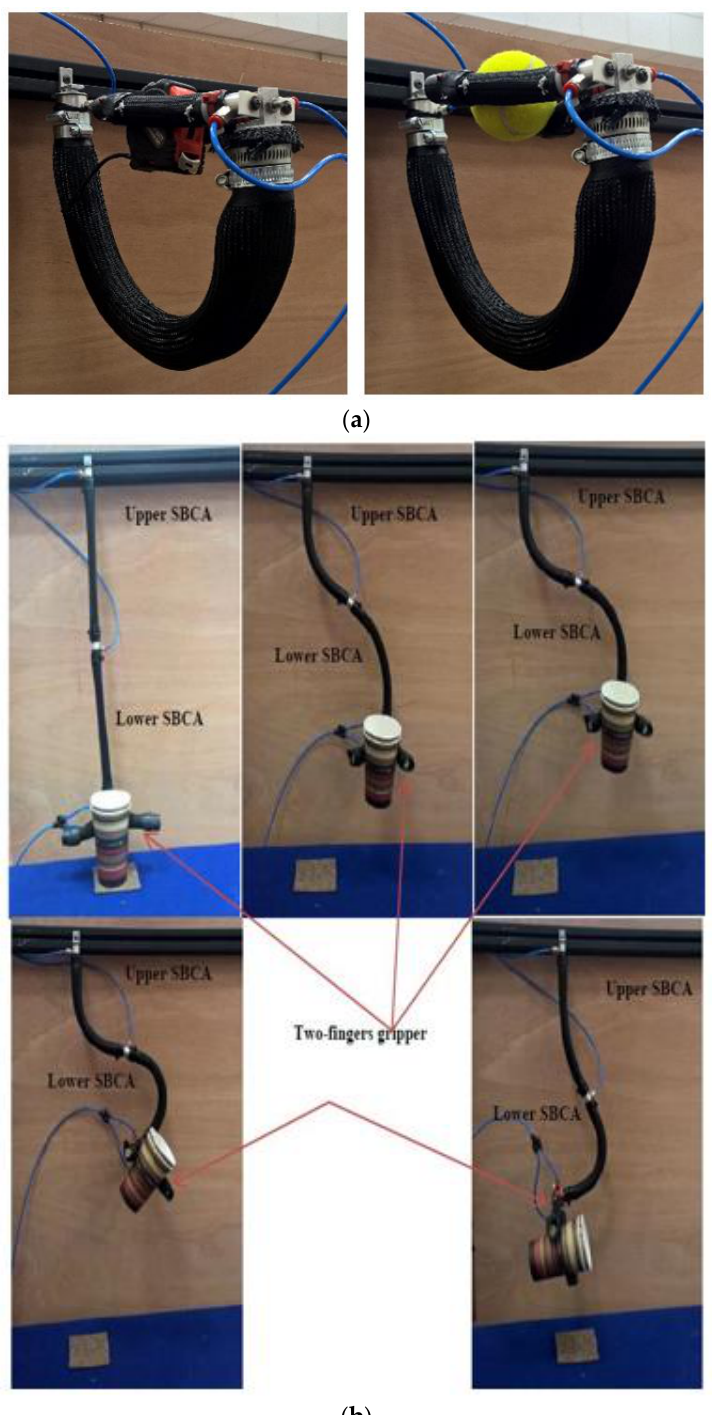
Figure 13. Continuum arms based on SBCA and a two-finger soft gripper. ( a ) A single SBCA. ( b ) Two SBCAs in opposite bending directions.